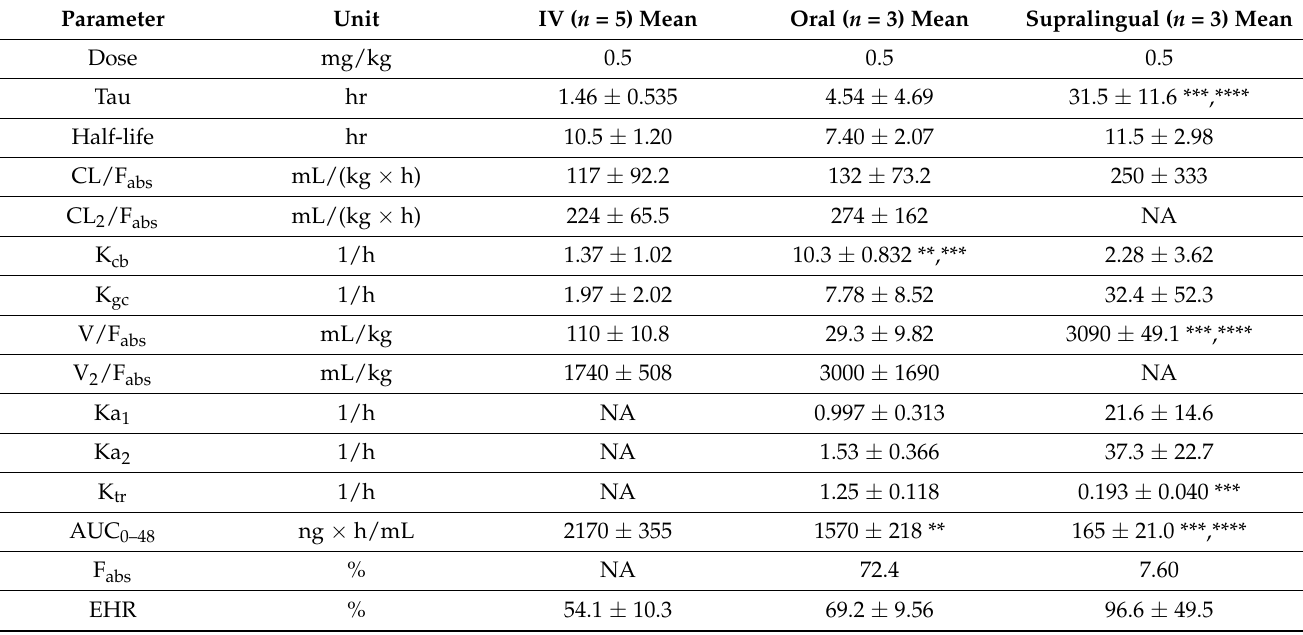
Figure 1. Structural models developed to analyze mycophenolic acid in rat plasma after three different routes of administration: ( a ) IV; ( b ) Oral; ( c ) supralingual administration. A bile : Amount in bile; A gut : Amount in the intestinal compartment. See Table 1 for the meaning of the different pharmacokinetic parameters. Table 1. Mean PK parameters after IV, oral, and supralingual administrations of MPA.